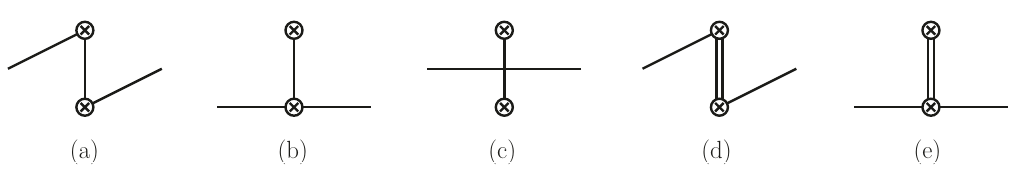
SS ; PP ; V 0 V 0 ; A 0 A 0 in chiral perturbation h i h i h i h i SS ; V 0 V 0 and to h i h i PP ; A 0 A 0 . The resonance exchange graphs (d) and (e) can contribute to h i h i